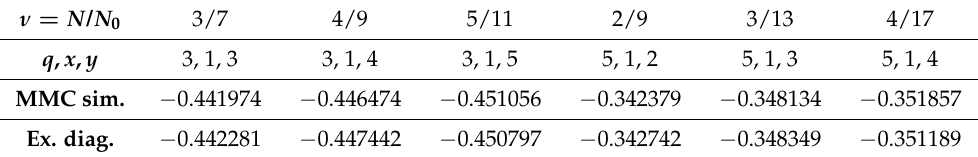
Table 3. Comparison of energy values (per particle in units, (Ex. diag.) and by quantum Monte Carlo simulation (MMC sim.) for few exemplary filling fractions in GaAs with FQHE corresponding to patterns q , x , y (cf. Equation (6)) (Metropolis Monte Carlo simulation for the proposed topology-based wave functions for 200 particles